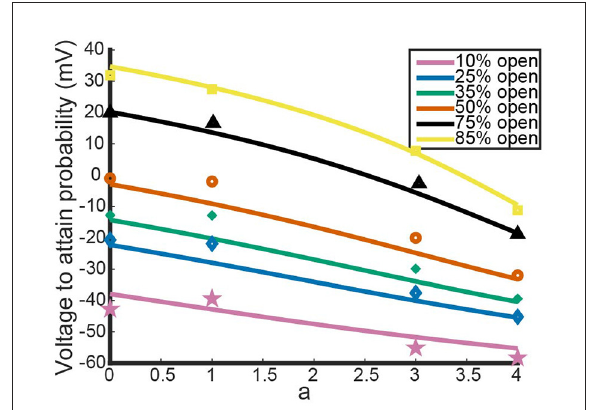
FIGURE4 Different fits of a four gate model for K v 1.1 and K v 1.2 homomers to the Al-Sabi one gate model data. The best fit model generated from a nonlinear least squares fitting method is shown as a black curve for both channel types. The light blue curves are the other seven overlapping fit K v 1.1 models that have the same order of magnitude as the best fit K v 1.1 curve. The orange curves are the other overlapping eight fit K v 1.2 models that have the same order of magnitude as the best fit K v 1.2